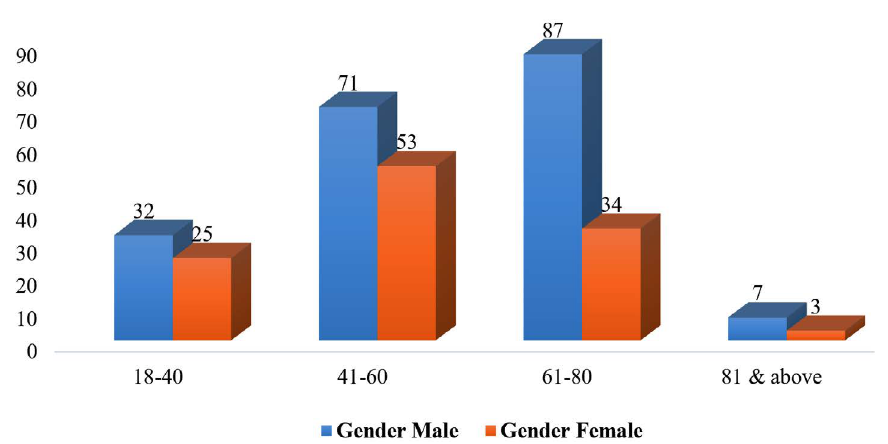
Fig. 1. Distribution of patients based on age and